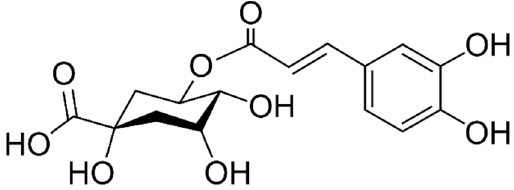
Figure 2. Chemical structure of chlorogenic acid.